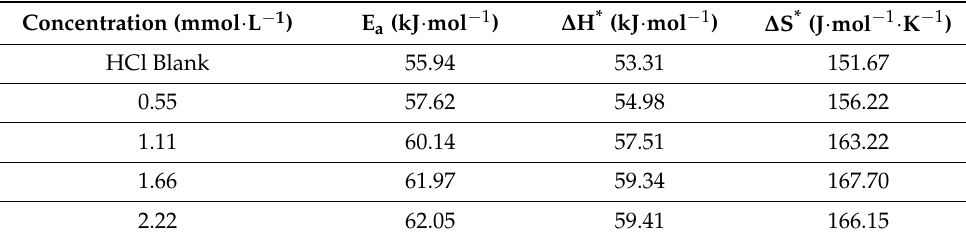
Figure 8. Arrhenius plots for the corrosion current densities (log i) versus 1/T for C-steel at different concentrations of the Q-22 inhibitor in 5 M HCl. Table 5. The activation energy of C-steel in 5 M HCl in the presence and absence of different Q-22 concentrations as obtained from the Arrhenius plots.